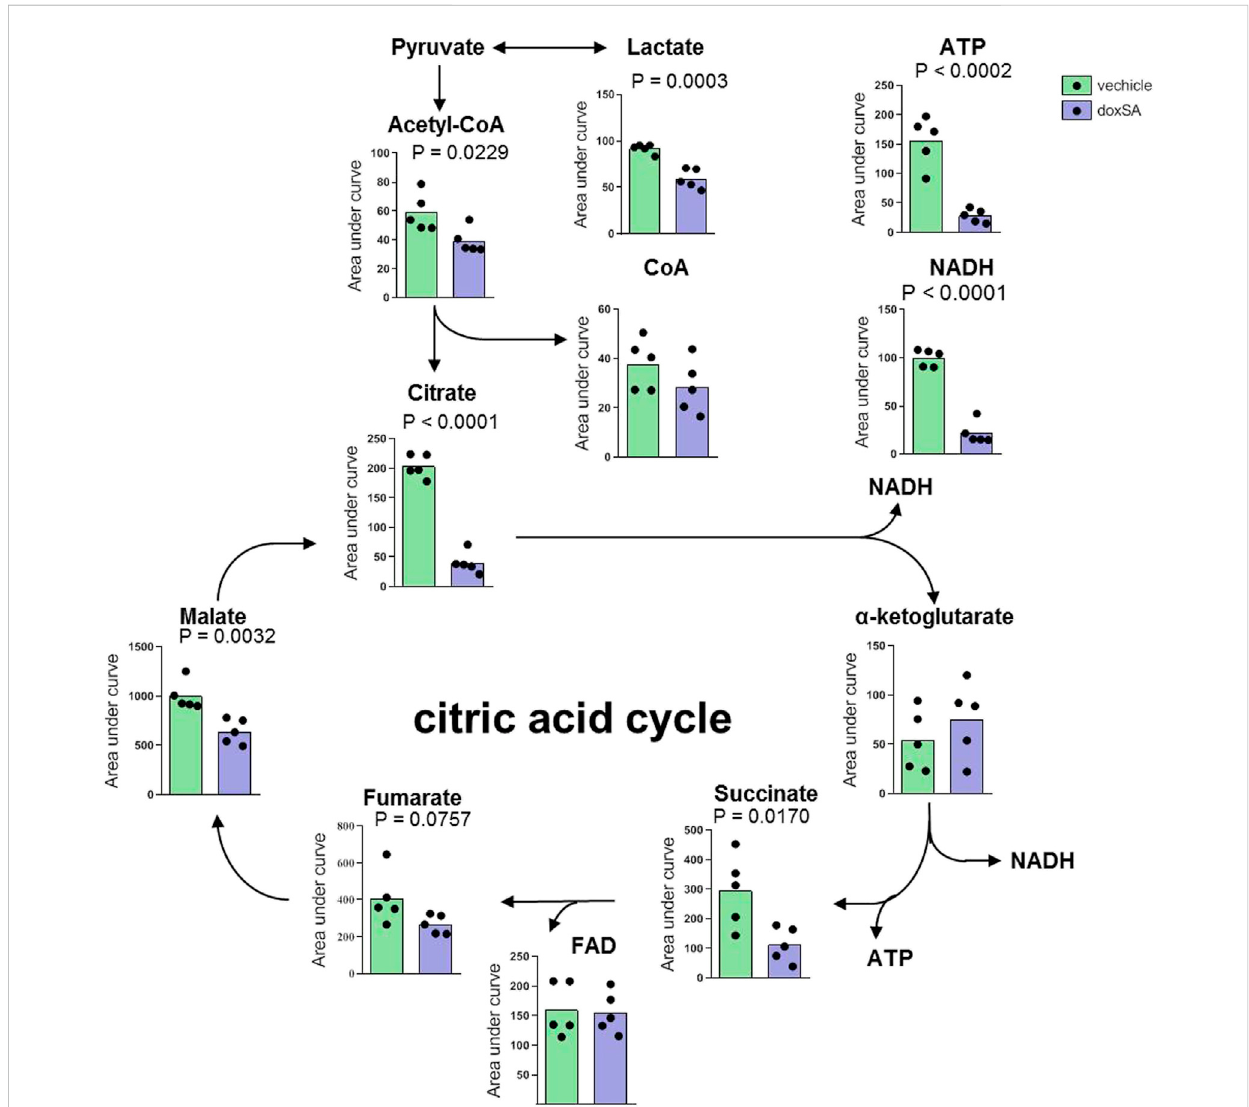
FIGURE 2 Intracellular citrate cycle-related metabolite pro fi le after doxSA exposure. HK-2 cells were exposed to the vehicle or doxSA at the extracellular concentration of 1 μ M for 24 h. The quantitative analysis of the differentially expressed metabolites related to citrate cycle and ATP synthesis.